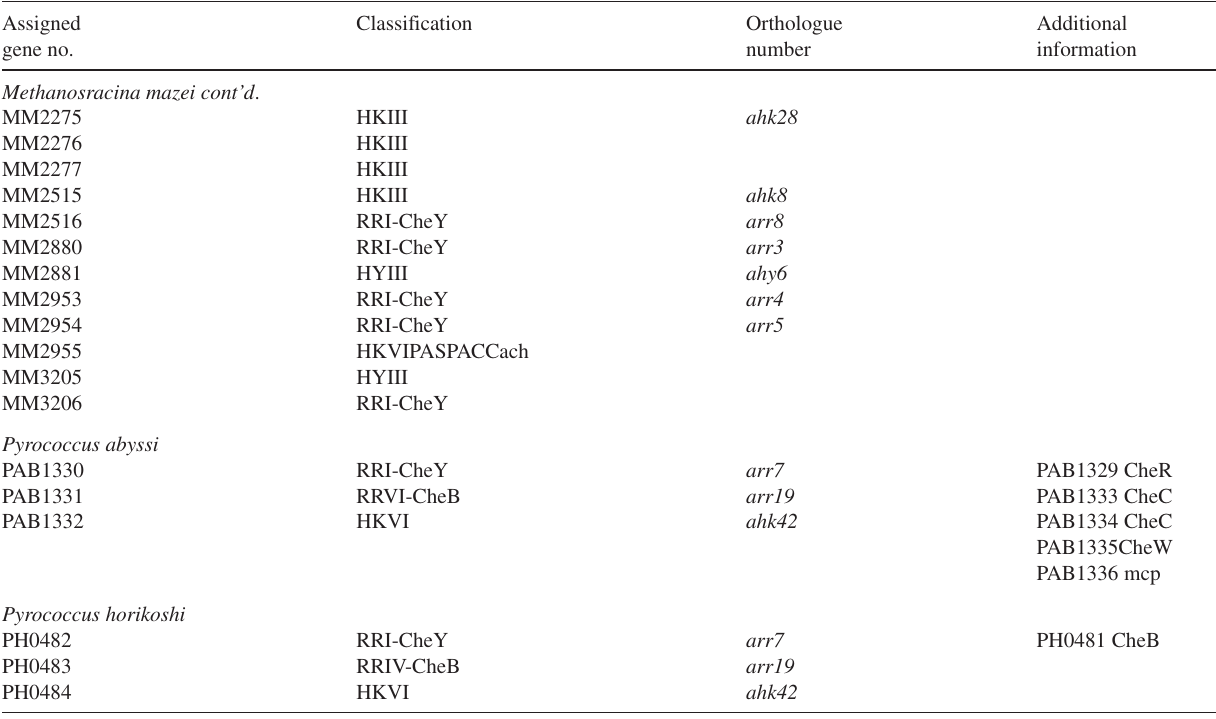
Table A2. Cont’d. Closely linked genes that may be part of